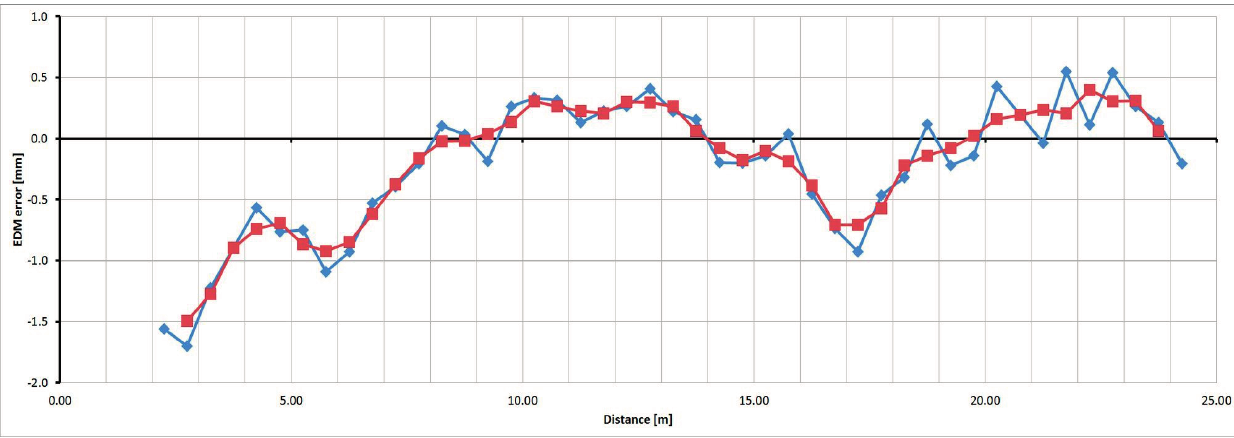
Figure 29. Relative errors of the Trimble M3 instrument (measured blue, averaged